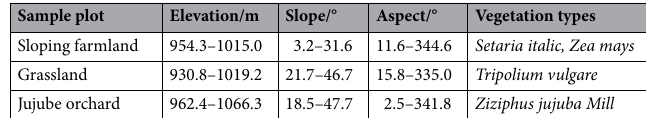
Table 2. Basic information of the study